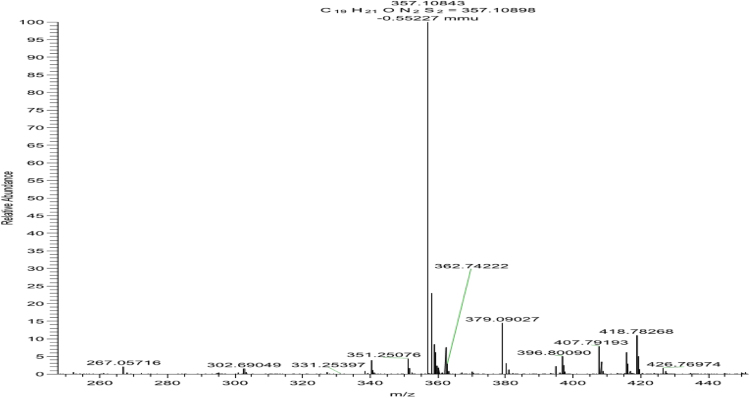
HRMS of Compound 4a.